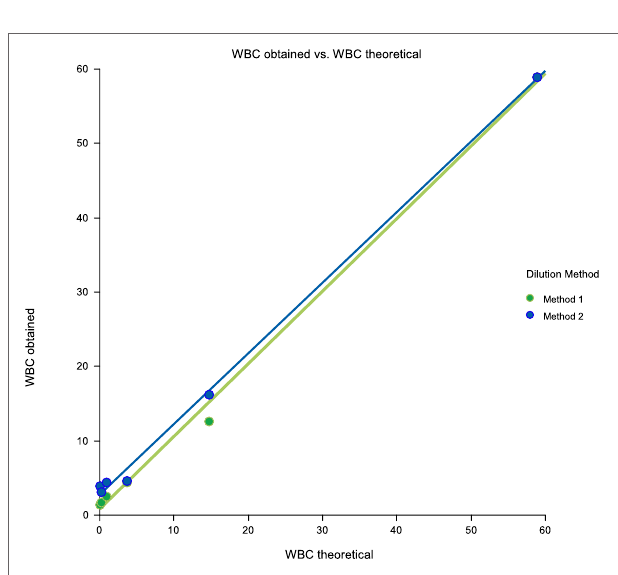
FIgURe 3 | Scatter diagram of obtained and theoretical white blood cell (WBC) in sample